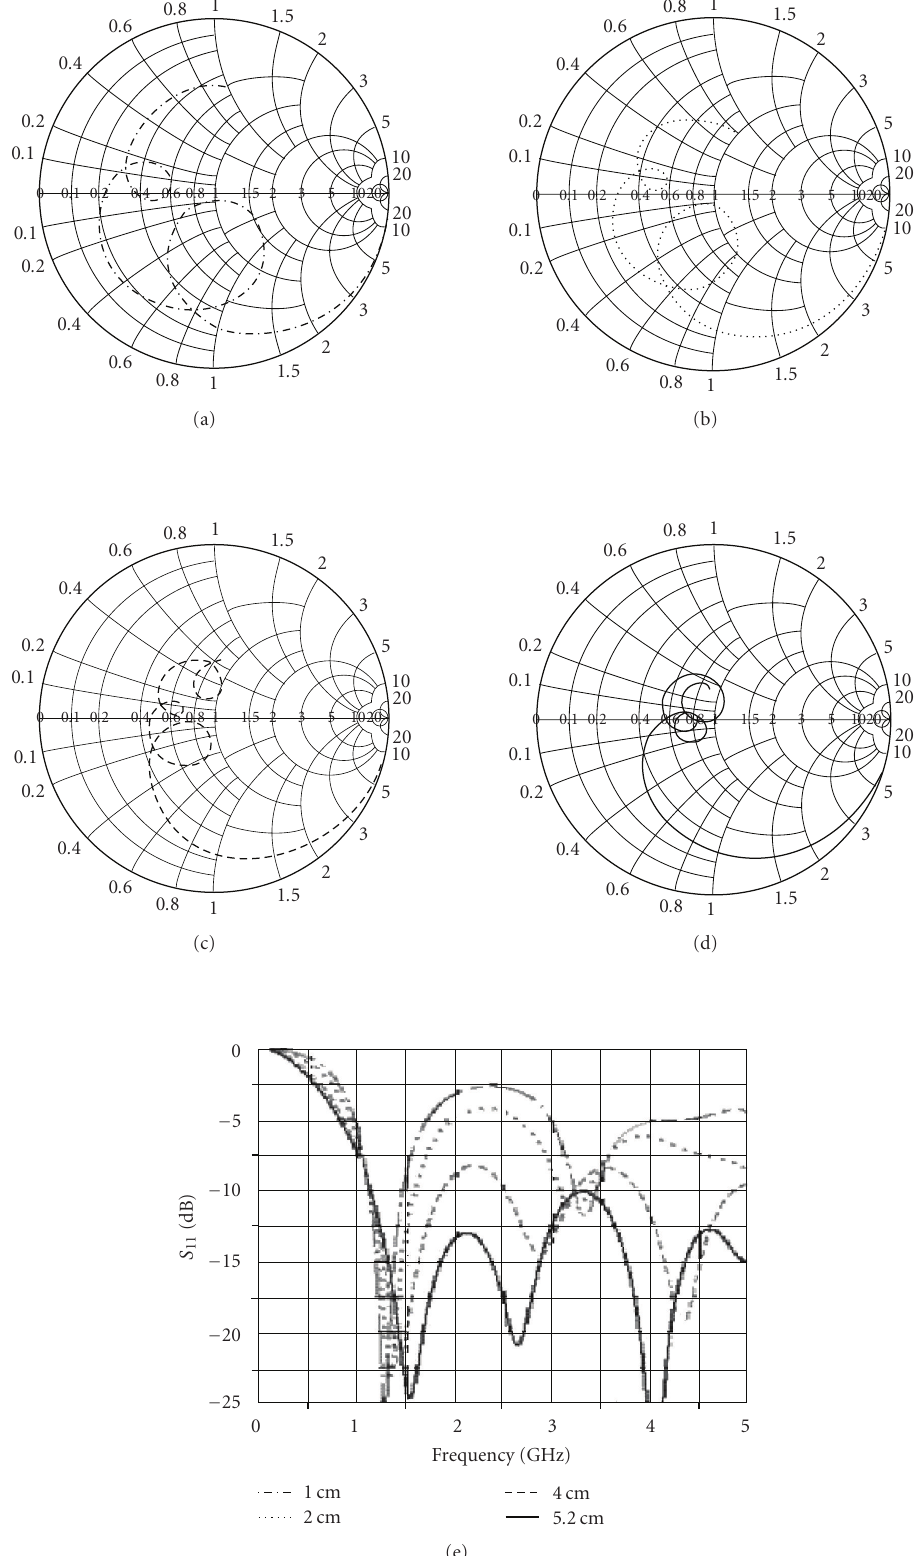
Figure 5: Impedance loci and return loss plot of four PEMAs with 2 A = 4 . 8 cm and 2 B equal to (— - —) 1cm, (- - - -) 2cm, (– – –) 4 cm, and (—–) 5.2